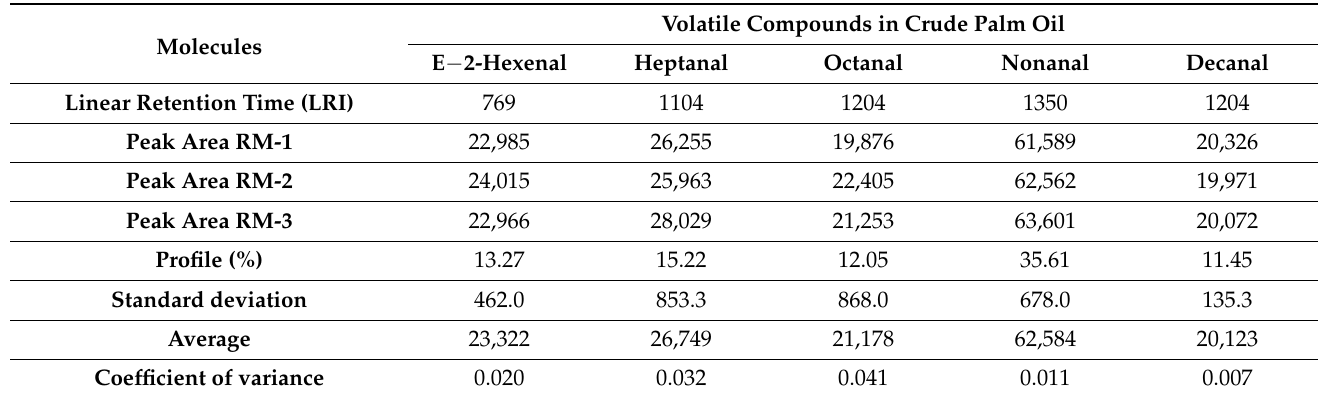
Table 2. Profile of the main volatile organic compounds of fresh crude palm oil.